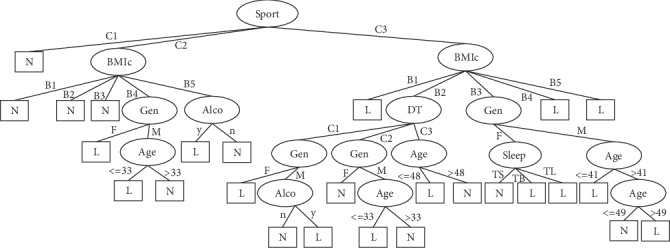
Decision tree #3 to classify risk factors of stroke.